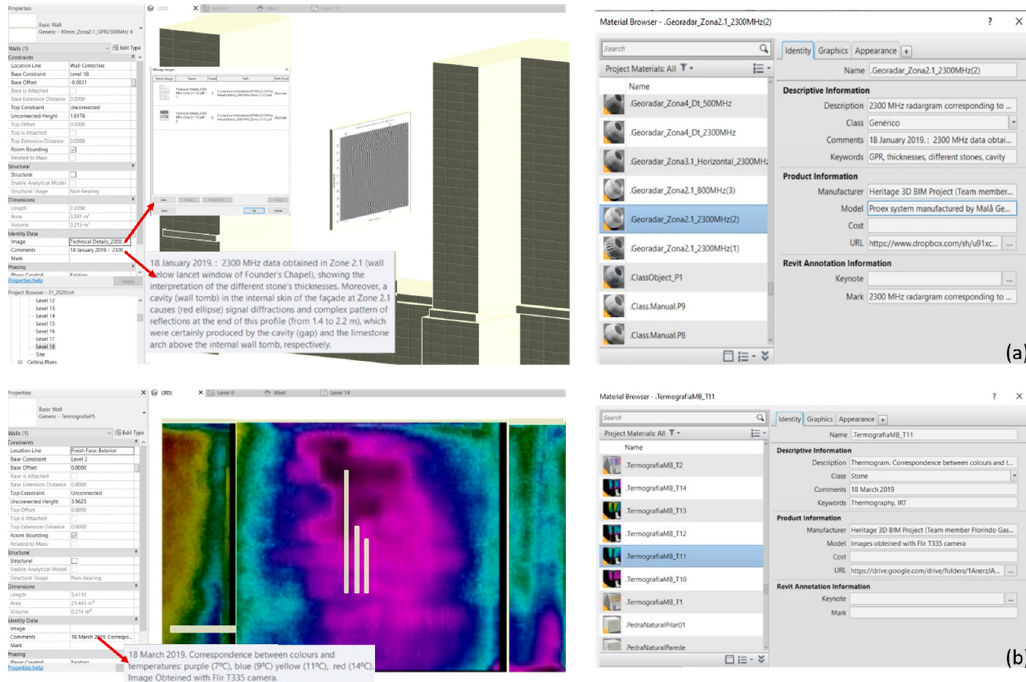
Figure 17. Revit database information associated to ( a ) the 2300 MHz radargram corresponding to Zone 2.1 and ( b ) the infrared thermography images.